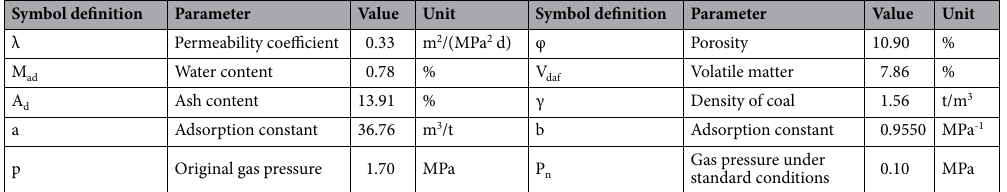
Table 2. Gas parameters.